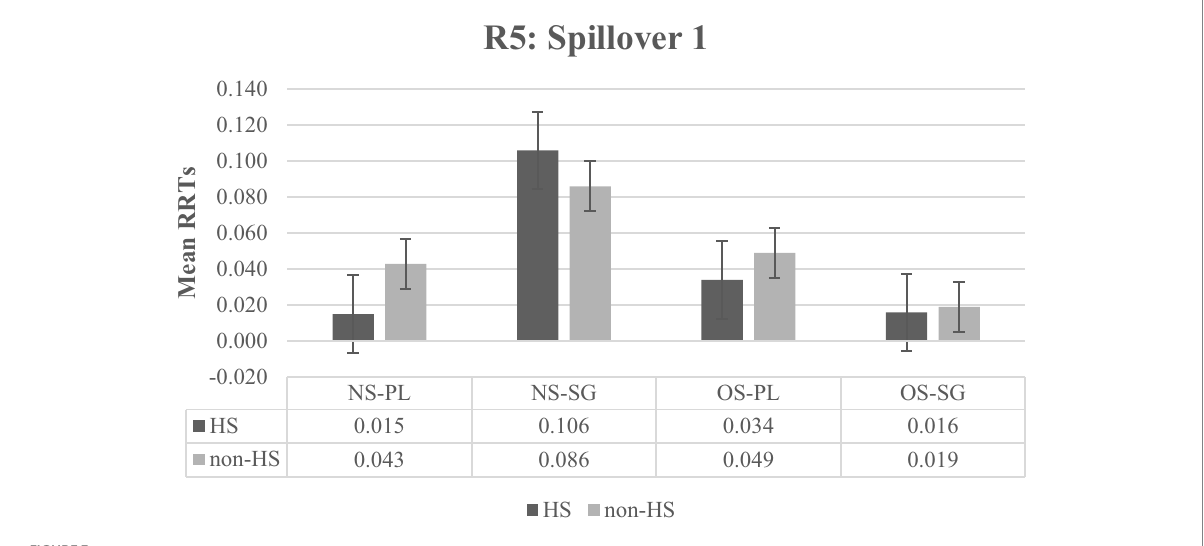
FIGURE 3 Mean RRTs of both groups for Region 5 (Spillover 1). RRTs, Residual reading times; HS, Heritage speakers; non-HS, Non-heritage speakers; NS, Null subject; OS, Overt subject; PL, Verb is plural-marked; SG, Verb is